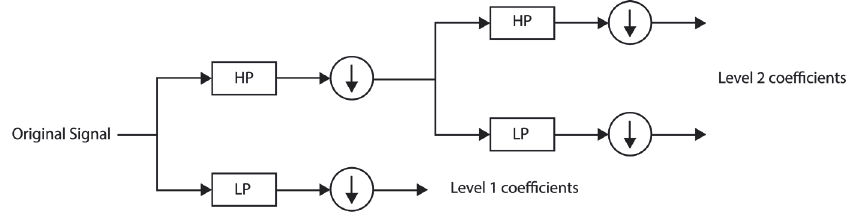
Fig. 2. Wavelet decomposition algorithm.